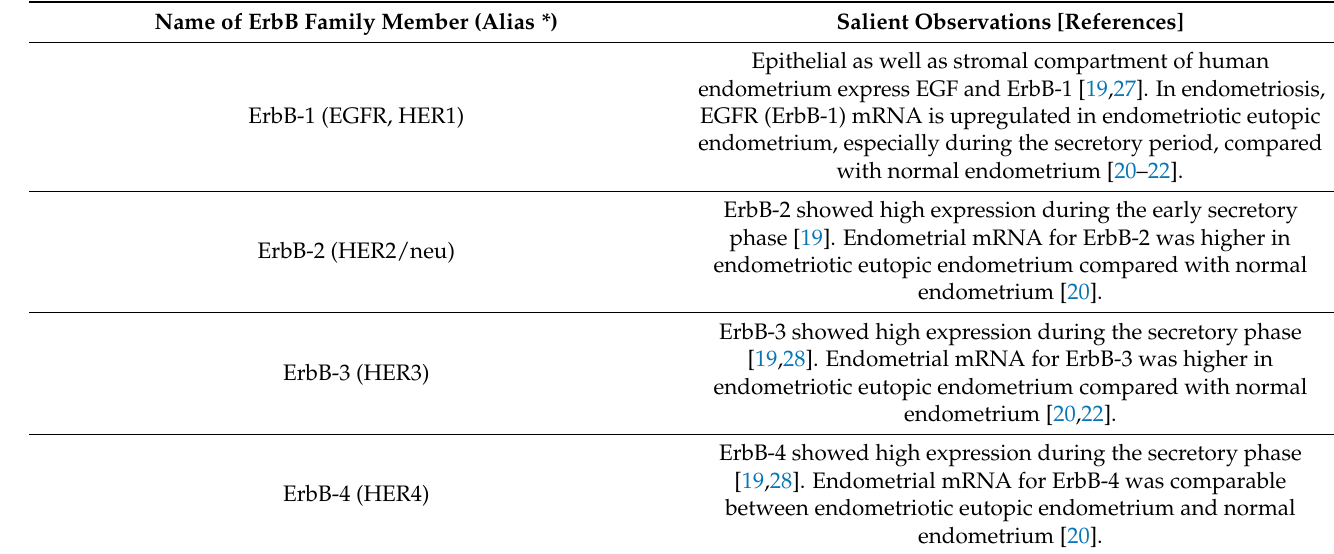
Table 1. Expression of ErbB family members in endometrium during